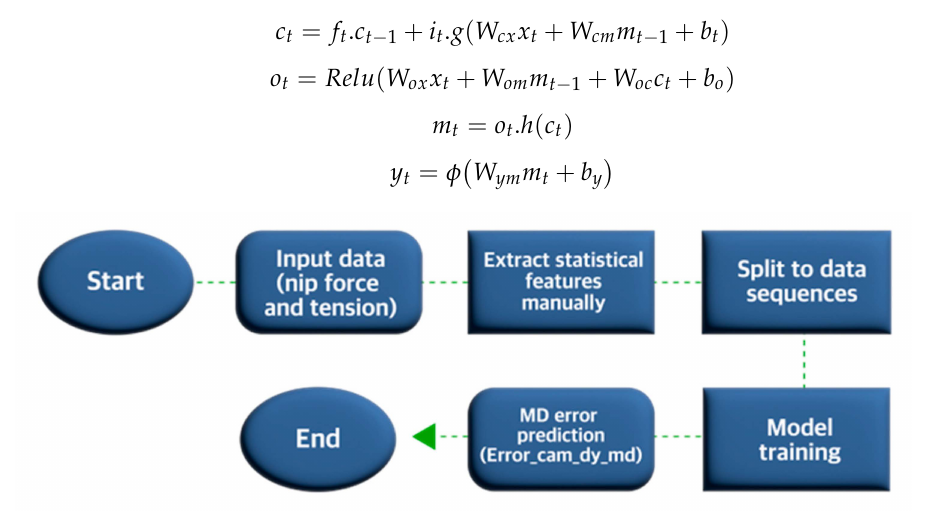
Figure 2. Diagram illustrating the introductory digital twin based on a predictive model.